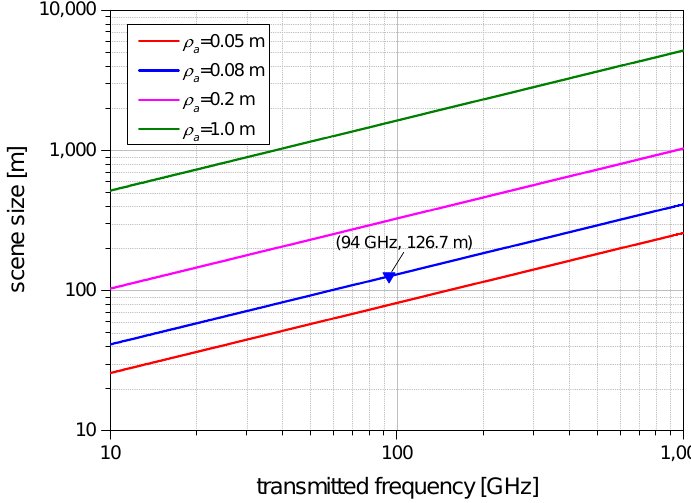
Figure 5. Scene size limitation of polar format algorithm (PFA).